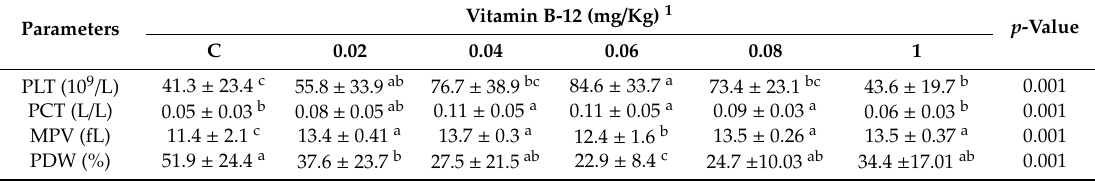
Vitamin B-12 (mg / Kg) 1